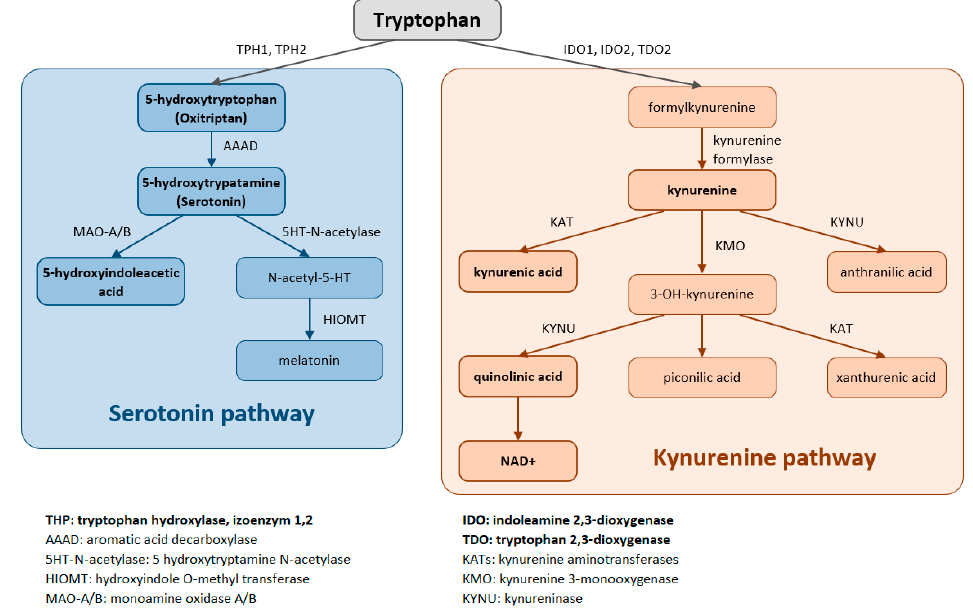
Figure 1. Tryptophan is metabolized by two pathways—the serotonin and the kynurenine pathways. The aromatic Trp core is conserved in the serotonin pathway . The first step in the metabolic cascade is Trp hydroxylation to form 5-hydroxytryptophan (5-HTP, oxitriptan). This step is catalyzed by tryptophan hydroxylase (TPH), and of its two isoenzymes, TPH1 is active in peripheral tissues (gastrointestinal tract, skin) while TPH2 is active in neuronal cell types. Subsequently, aromatic acid decarboxylase (AAAD) removes the carboxyl group to form 5-hydroxytryptamine (5-HT, serotonin). The final product of this pathway is melatonin (N-acetyl-5-methoxy-tryptamine). The majority (up to 90%) of all Trp is metabolized by the kynurenine pathway , where the intermediates are ligands for Aryl hydrocarbon receptors (AHRs) that primarily influ- ence immune responses. In this metabolic pathway, the aromatic core is destroyed. The limiting step for its initiation is activation of two oxidoreductases—indolamine-2,3-diox- ygenase (IDO) and tryptophan-2,3-dioxygenase (TDO). The IDO1 isoform is expressed in most tissues at low levels, including in macrophages, placenta, and epididymis, but not in the liver. The IDO2 isoform is found in the liver, brain, testes, endometrium, placenta, thyroid and can be induced in antigen- presenting cells and B lymphocytes. TDO is found mainly in the liver, but can also be expressed in bone marrow, the immune system, muscle tissue, the urinary and gastrointestinal tracts, and in the brain. Both IDO isoforms (IDO1, IDO2) are activated by proinflammatory cytokines, the most potent IDO1 activator being in- terferon γ . On the other hand, TDO is mainly activated by cortisol and the hypothalamic-pi- tuitary-adrenal axis (HPA). The catabolites referred to as kynurenines include kynurenine (Kyn), kynurenic acid (KynA), quinolinic acid (QA) and the terminal products niacin (vitamin B3) and nicotinamide adenine dinucleotide (NAD+). The first rate-limiting step in the kynurenine pathway is conversion of Trp to N-formylkynurenine. This step is mediated by TDO in the liver. Under normal conditions, this is the major metabolic pathway. But expres- sion levels of TDO are regulated by systemic levels of Trp, determined mainly by food intake and corticosteroids. Elevated levels of circulating glucocorticoids due to stress, sleep depriva- tion, or lack of physical activity, stimulate TDO expression. This leads to enhanced liver kynurenine metabolism and the subsequent increased delivery of kynurenines into the CNS. The situation is different with chronically high cortisol levels—it leads to glucocorticoid resistance, suppresses liver TDO expression and shifts to extrahepatic kynurenine